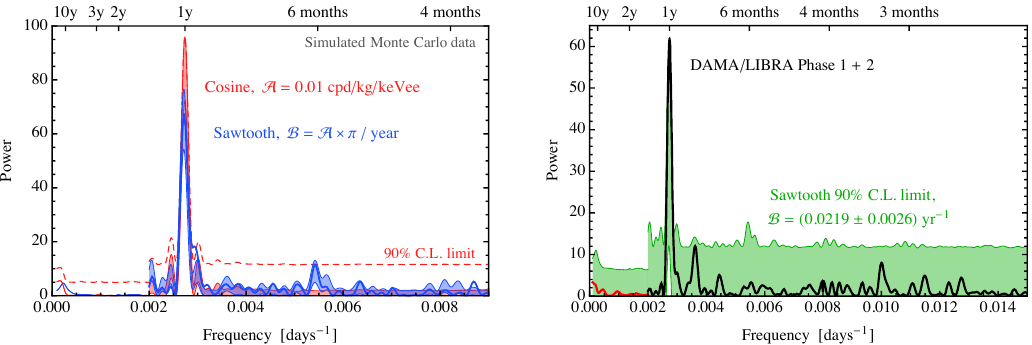
Figure 4 . Left: power spectra computed from Monte Carlo simulations assuming a sawtooth (blue line and band) and a cosine modulation (red band), with A = B (cid:1) yr =(cid:25) = 0 : 01 cpd = kg = keVee. The colored bands represent local 1 (cid:27) intervals. The red dashed line shows the global 90% C.L. limit for a sinusoidal signal. Right: power spectrum of the DAMA residuals (black) and annual rate (red) for Phase 1 and Phase 2 combined, taken from [6], together with the 90% C.L. allowed region (green) obtained from Monte Carlo simulations assuming a sawtooth with B = 0 : 0219 (cid:6) 0 : 0026 cpd = kg = keVee = yr as in the combined DAMA/LIBRA best (cid:12)t of table 1. In the left panel of (cid:12)gure 4 we show the power spectrum (Lomb-Scargle periodogram as de(cid:12)ned in [38]) corresponding to data simulated assuming a sawtooth as in (cid:12)gure 2 (blue), and compare it to the power spectrum of a simulated annual cosine modulation (red) with A = B (cid:1) yr =(cid:25) = 0 : 01 cpd/kg/keVee. We computed the power spectrum following the procedure adopted by the DAMA collaboration in [6]. In the (cid:12)gure, the colored regions correspond to local 1 (cid:27) intervals, computed by simulating 100 Monte Carlo samples; the red dashed line shows the global 90% C.L. allowed region, where all the peaks are